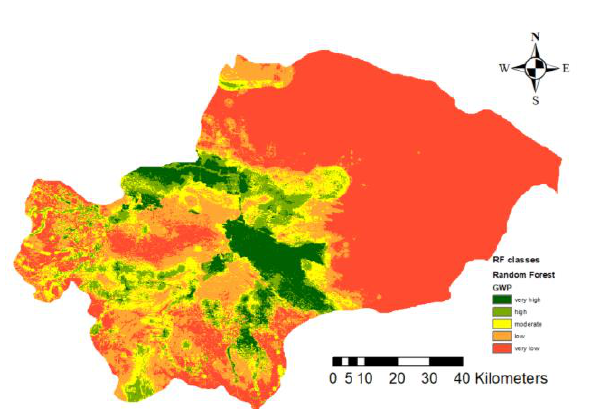
Figure 6 . GWPM of Random Forest